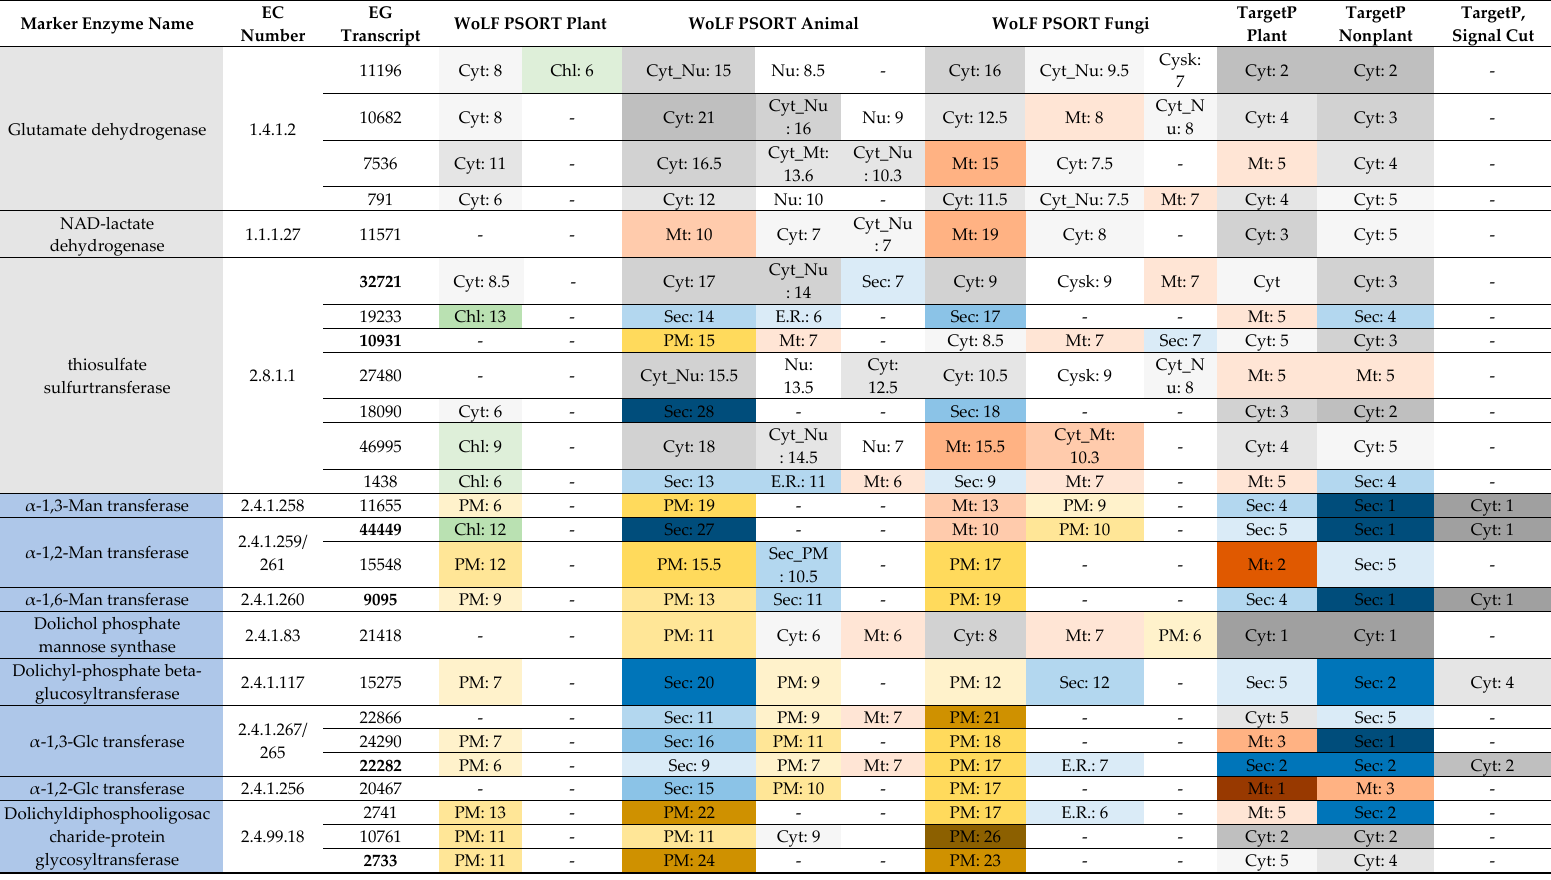
Metabolites 2019 , 9 , x FOR PEER REVIEW Table 2. Subcellular location prediction of E. gracilis cytosol (grey) and Golgi (blue) marker proteins.